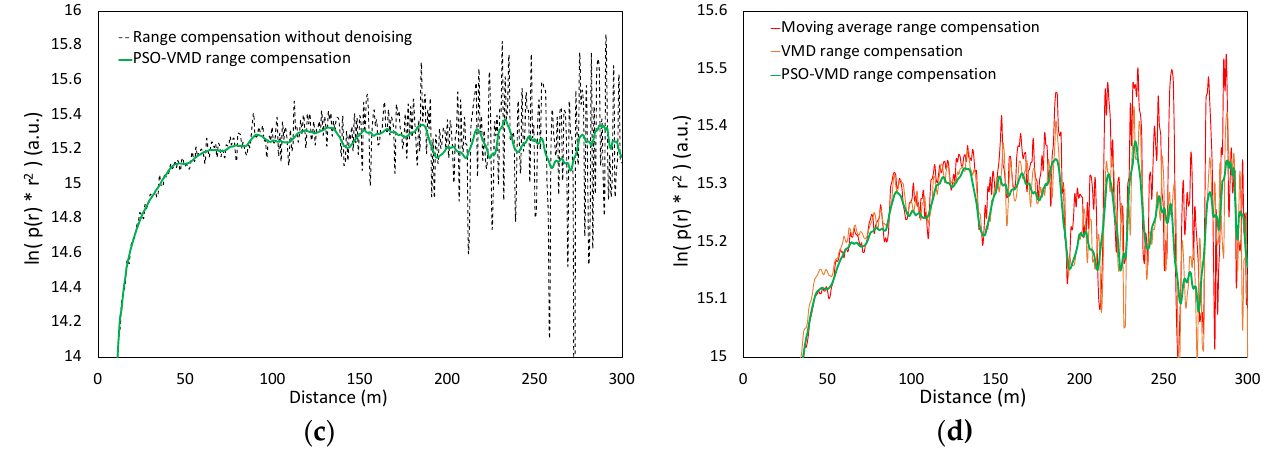
Figure 6. LED-lidar echo range compensation: ( a ) moving average; ( b ) VMD; ( c ) PSO-VMD; ( d ) comparison of ( a – c ).